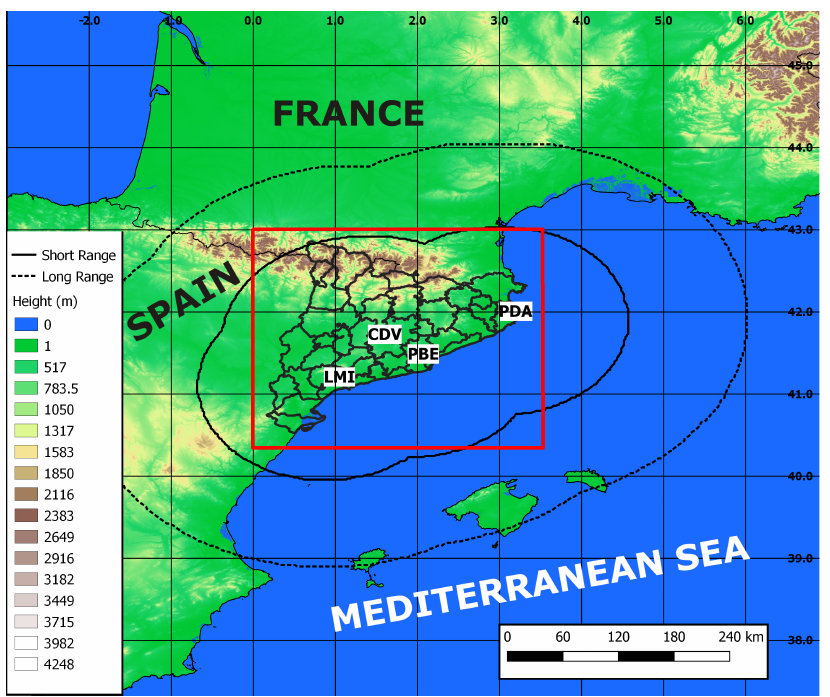
Figure 1. Topographic map of the area of study (marked with the red rectangle). The three-letter acronym labels (CDV = Creu del Vent, PBE = Puig Bernat, PDA = Puig d’Arques, and LMI = La Miranda) indicate the location of the radars. The short (straight) and long (dashed) radar ranges are indicated by the black